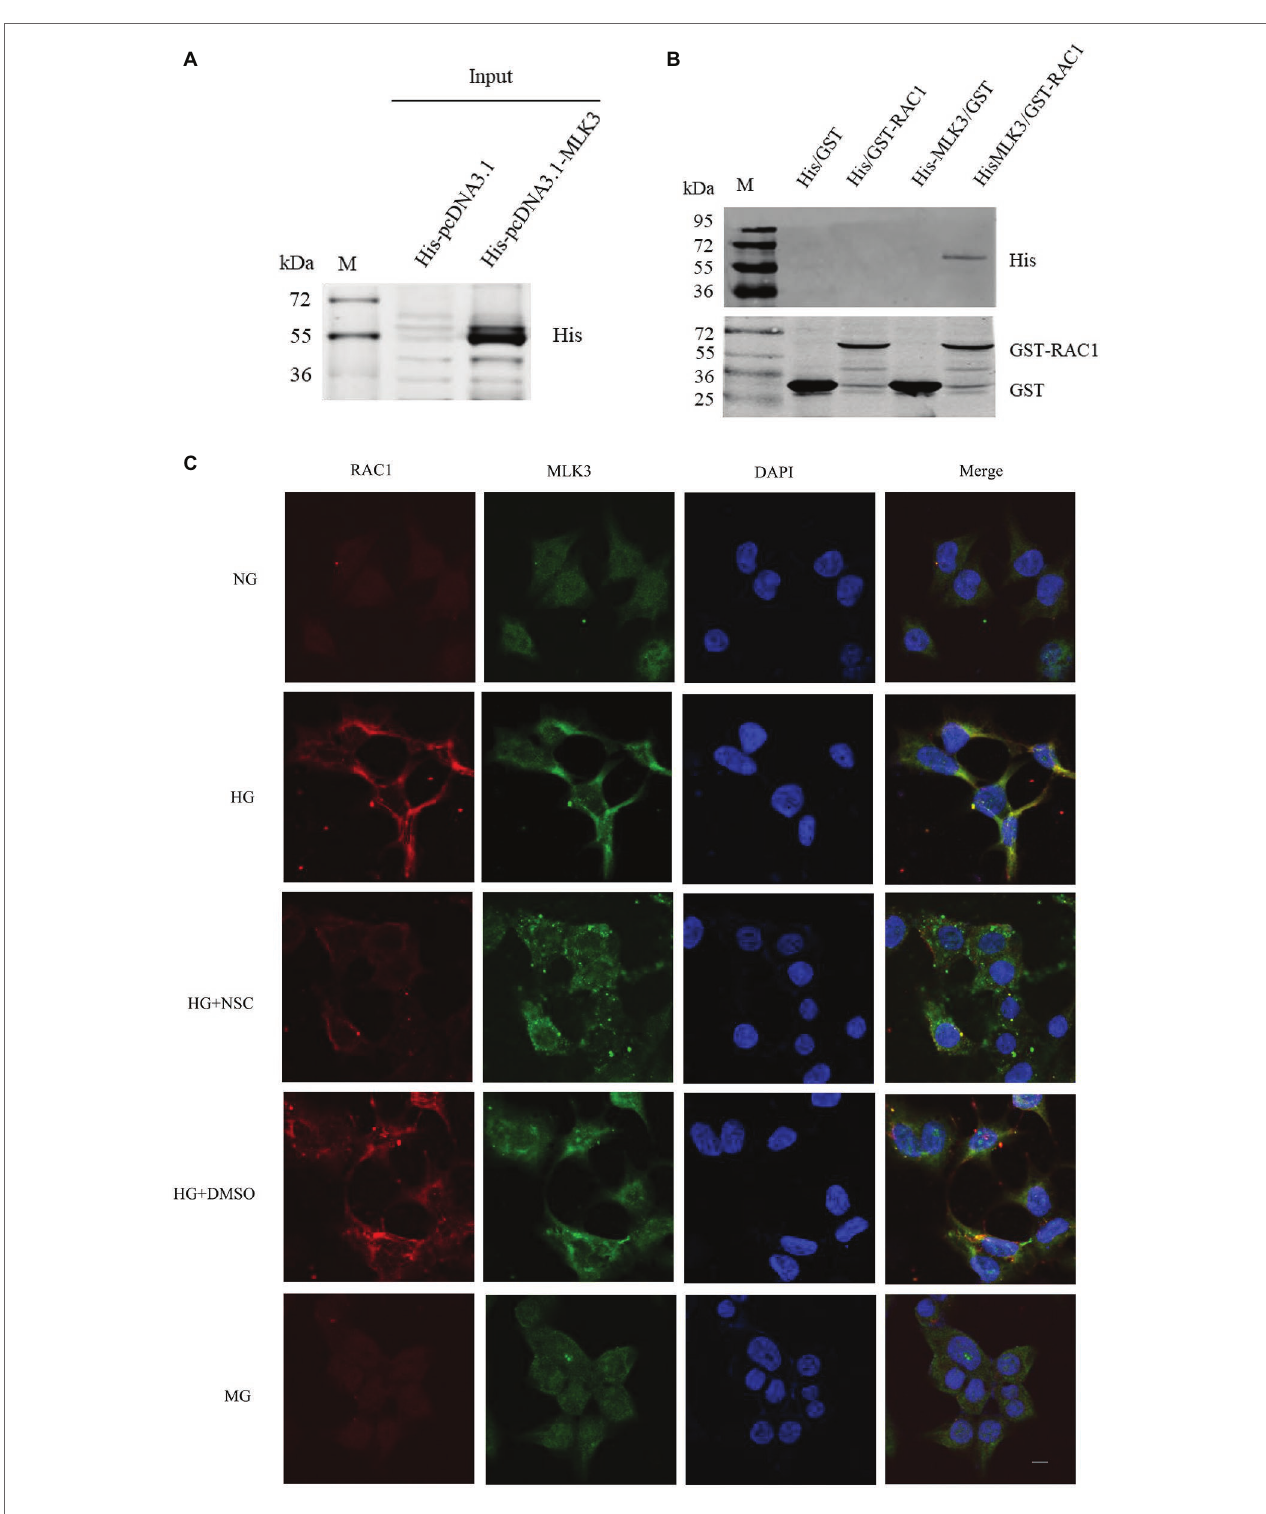
FIGURE 6 | RAC1 interacts directly with MLK3. (A) sodium dodecyl-sulfate polyacrylamide gel electrophoresis (SDS-PAGE) and Western blotting (WB) of His- tagged MLK3 fusion protein detected in a pull-down experiment using an anti-His antibody. (B) His-tagged MLK3 interacts directly with GST-RAC1 detected by SDS-PAGE and WB with anti-GST and anti-His antibodies. (1) GST as prey protein and His-pcDNA3.1 as bait protein. (2) GST-RAC1 as prey protein and His- pcDNA3.1 as bait protein. (3) GST-PGEX-4 T-1 as prey protein and His-pcDNA3.1-MLK3 as bait protein. (4) GST-PGEX-4 T-1-RAC1 as prey protein and